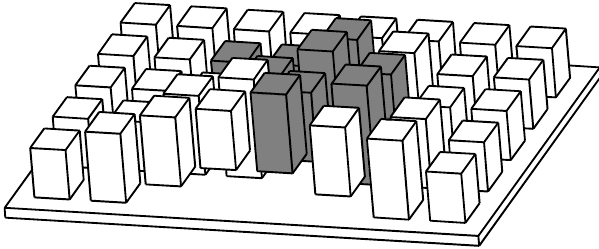
Figure 12. Schematic diagram of the improved node information.